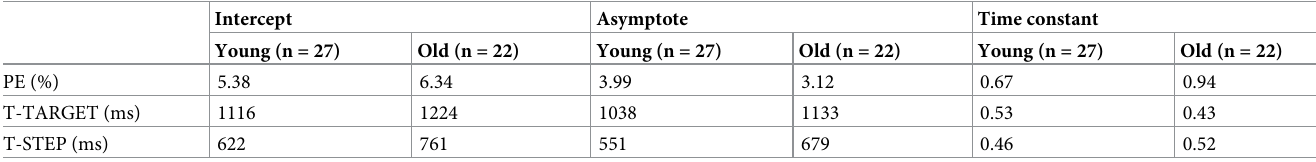
Table 2. Performance curve parameters for the participants in Experiment